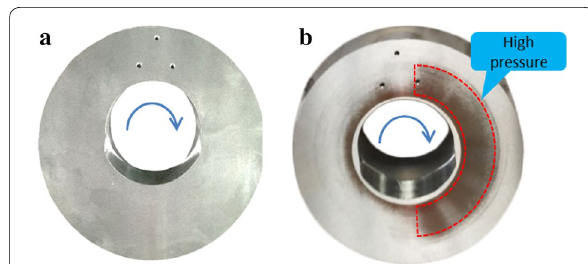
approved the final manuscript.